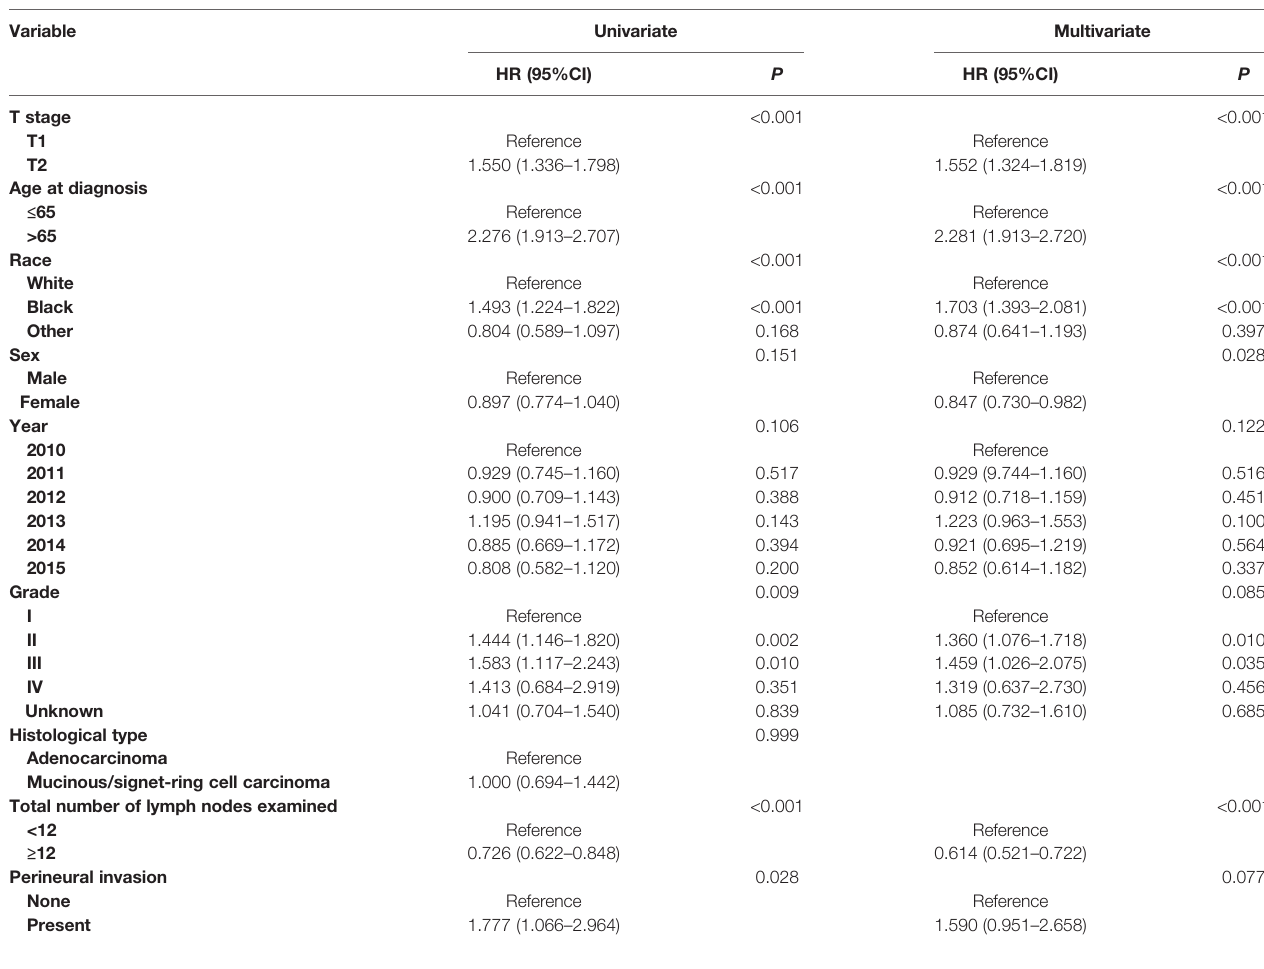
TABLE 2 | Univariate and multivariate survival analyses of stage I colon cancer. Variable Univariate